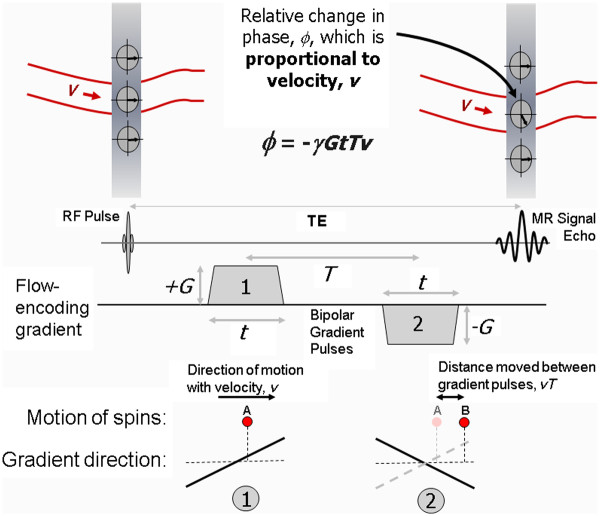
This diagram illustrates how velocity-related phase shifts are caused by blood flowing along the direction of two equal but opposite magnetic field gradients applied in succession, (bipolar gradient pulses). Two gradient pulses are shown with gradient amplitudes G and duration t, separated by a time T. Immediately after the rf pulse is applied, both moving and stationary spins have the same phase (top left). When the first positive gradient pulse is applied (1), spins at position A experience an increase in magnetic field due to their position along the gradient. When the second negative gradient pulse is applied
[2], stationary spins that remain at position A experience an equal decrease in magnetic field, causing the spins to move back into phase with one another. Spins in moving blood with velocity v, however, will have moved to position B, and experience an additional decrease in magnetic field that is proportional to the distance moved, vT, from position A. The signal from moving blood therefore acquires a phase shift, ϕ, relative to that of stationary tissue, that is proportional to velocity, v as shown (top right). Bipolar gradient pulses are used to design velocity-sensitive pulse sequences. From the equation shown (top centre) it can be seen that the velocity-related phase shift, ϕ, is also proportional to amplitude G, the duration, t, and the separation, T, of the gradient pulses. Velocity sensitive pulse sequences are designed to be sensitive over different velocity ranges through careful choice of these gradient pulse parameters.